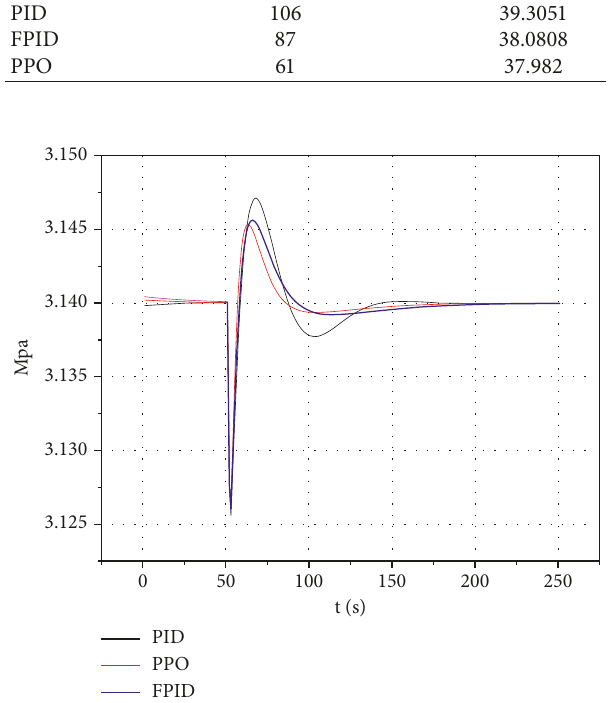
Figure 13: Simulation curve of steam pressure with feed water temperature step up to 80 °